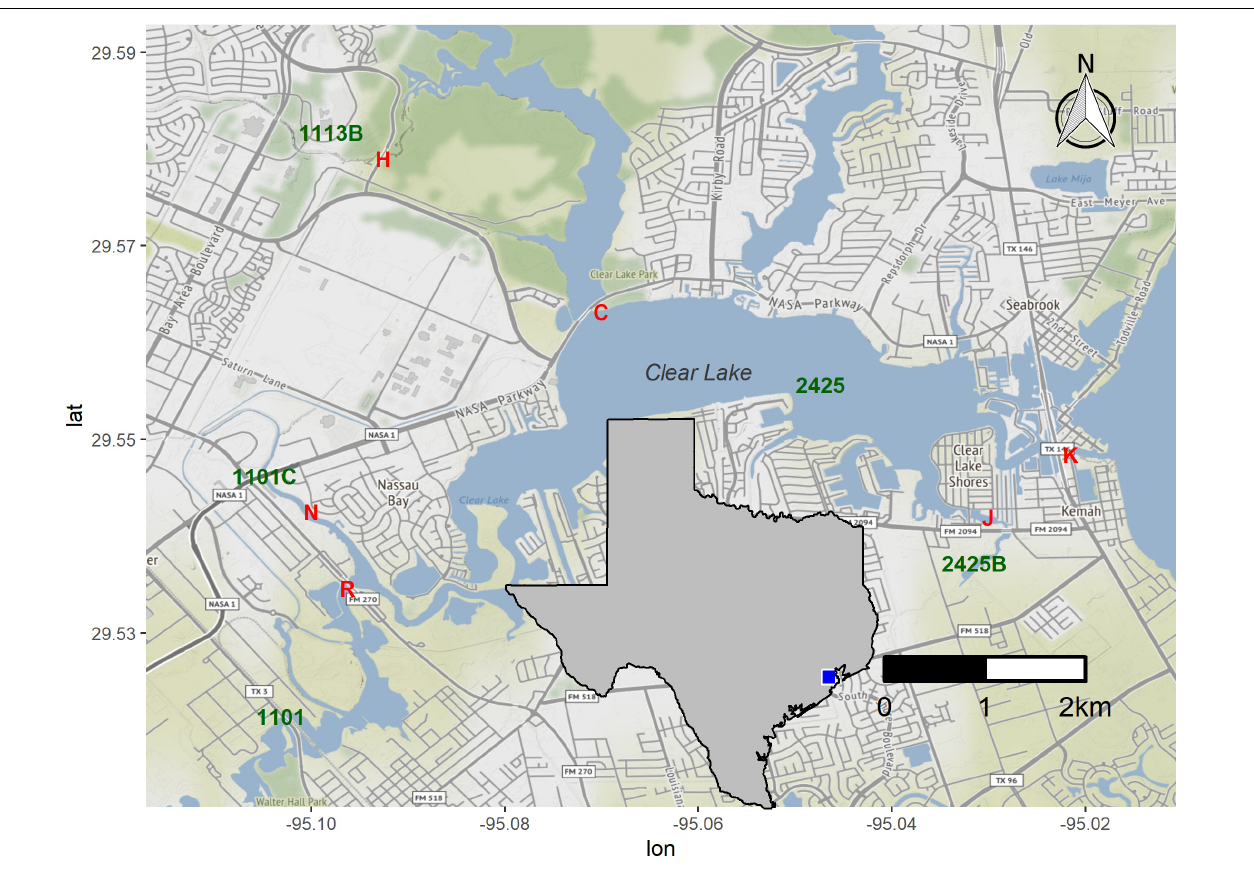
FIGURE 1 | Sampling stations around Clear Lake. Stations sampled in this study are indicated by red letters (H, C, K, J, R, and N). Water body segments as defined by the TCEQ (1113B, 2424, etc.) are indicated in green. Inset indicates study area within a map of Texas. Figure was generated with scripts in Supplementary File 1